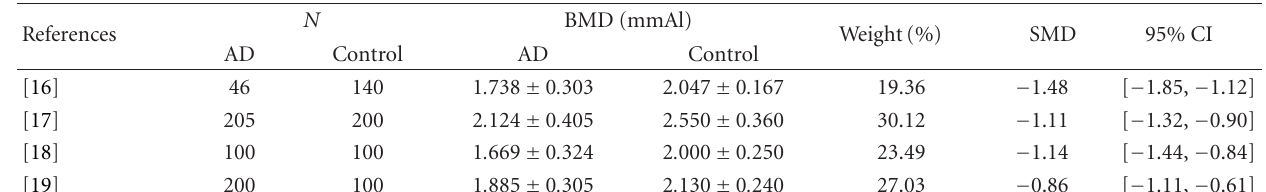
Table 4: Summary of the studies of the association between AD and hip BMD.